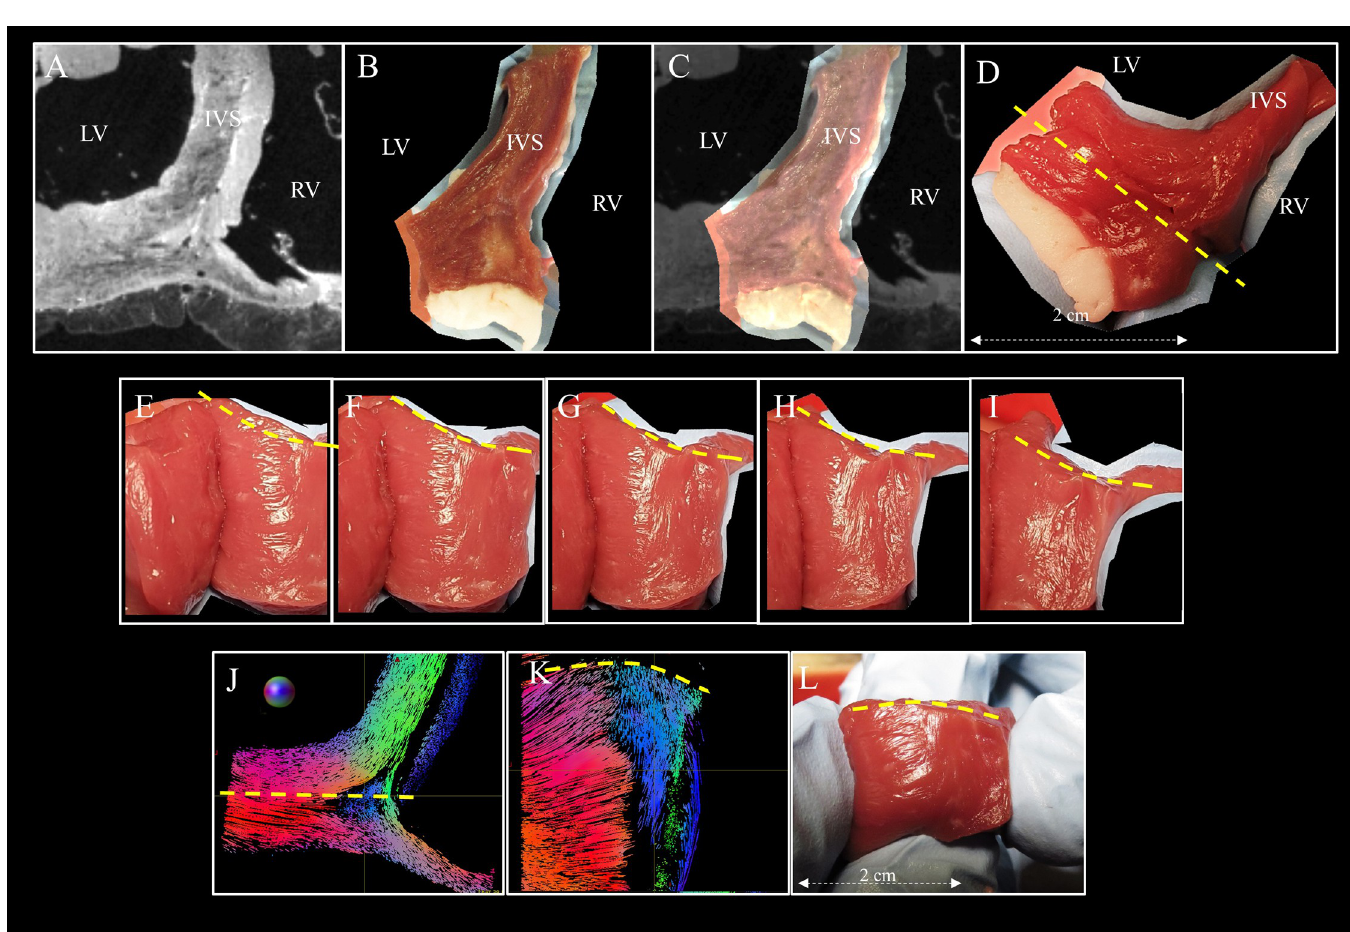
Fig 6. Macroscopic structural organization of the posterior junction. A) Anatomical Transversal images of sheep heart #2 of the posterior junction close to the base- ventricular level. B) Photography of the dissected heart #4. Corresponding view using anatomical images from sample #2 after rigid registration. C) Overlay of A) over B). D) Another transversal view of the posterior junction. A coronal cut was performed on a line (yellow line) ranging from the RV cavities to the LV posterior wall going through the suspected region. E to I) Visualization of the structural organization is presented by slightly rotating the sample while the surgical light highlights the macroscopic structural organization. J) Tractography in short axis view taken from sample #2 in a selected slice in the basal area K) Tractography in a long-axis view corresponding to the plane drawn by the yellow line. L) Another picture was taken in a long-axis view. Original photos are available to the